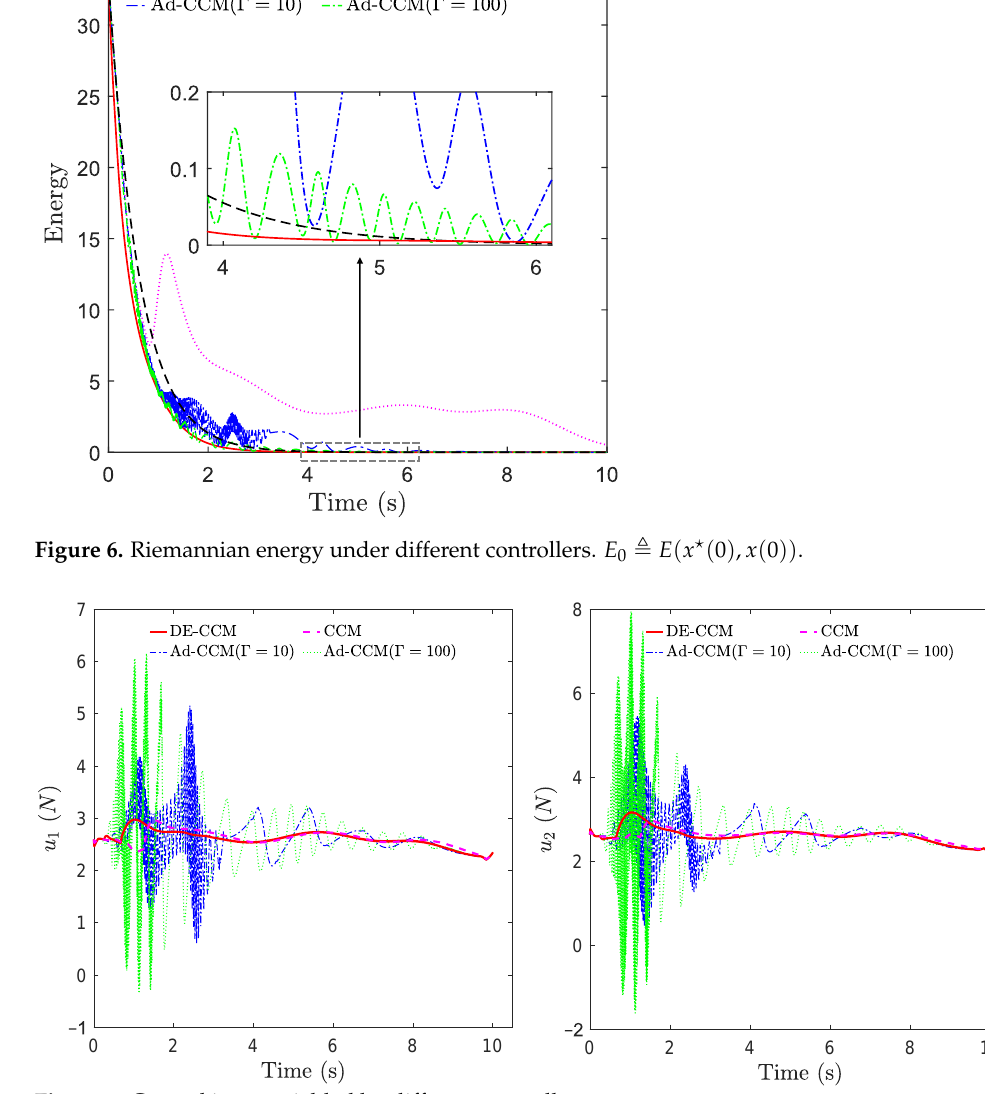
Figure 7. Control inputs yielded by different controllers. Table 2. MSE for state trajectory tracking for the planar quadrotor example. For Ad-CCM, only the result for Γ = 100, which corresponds to better tracking performance compared to Γ = 10, is